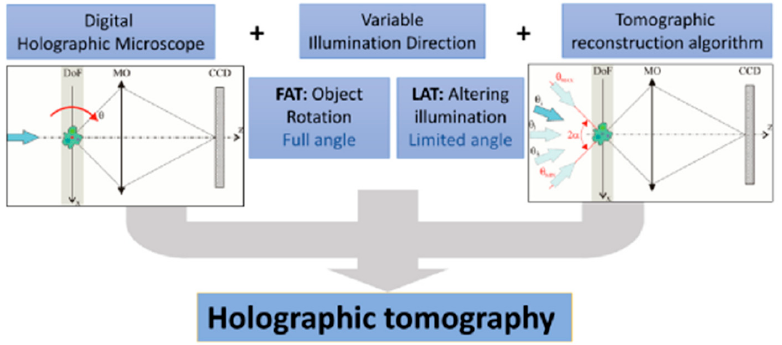
Figure 8. Basic modules of holographic tomography: FAT, full-angle tomography; LAT, limited-angle tomography [4].